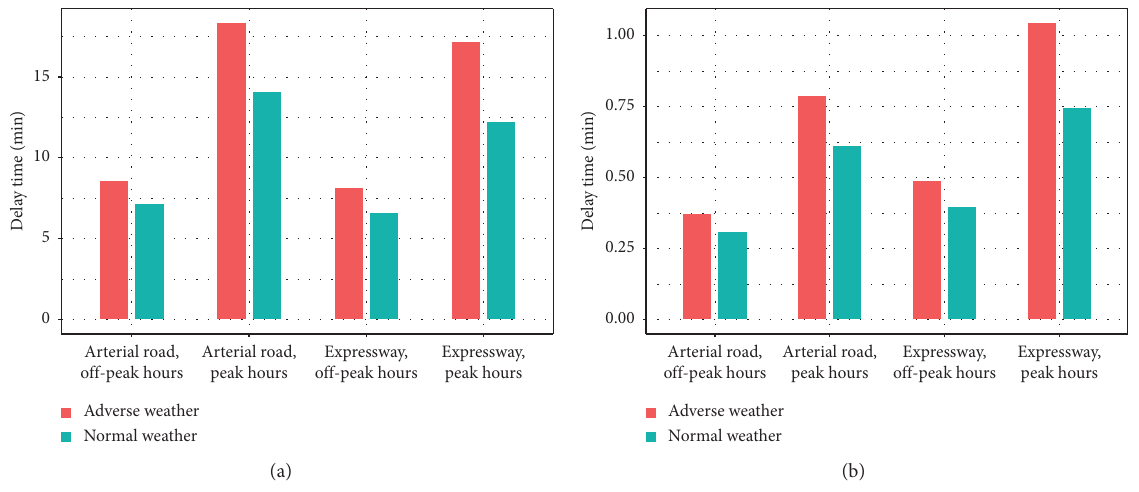
Figure 8: Travel delay under each condition. (a) Average delay and (b) average delay time